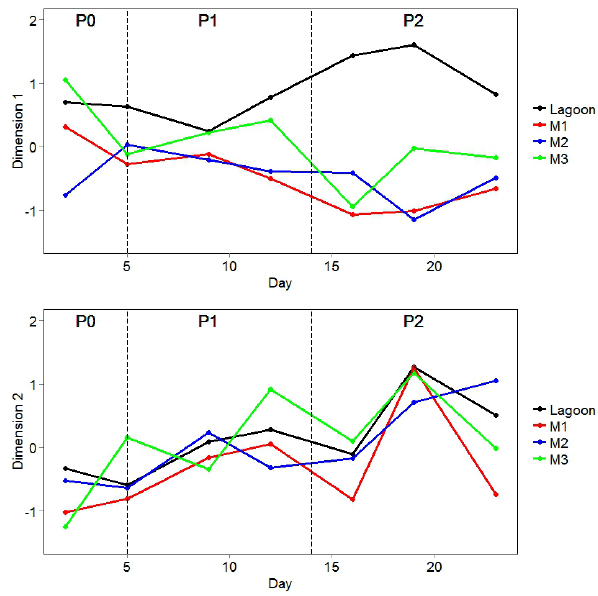
Figure 3. Proportional composition of zooplankton groups to total zooplankton abundance in the three VAHINE mesocosms (M1–3) and the lagoon waters.